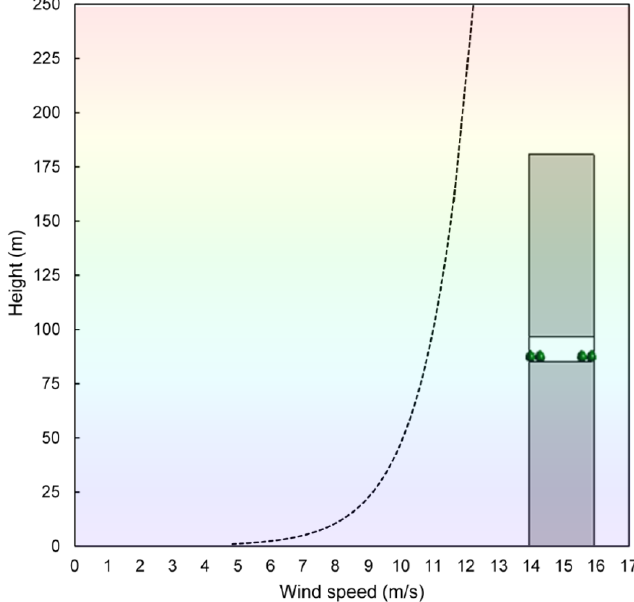
Figure 4. Atmospheric boundary layer wind velocity profile.